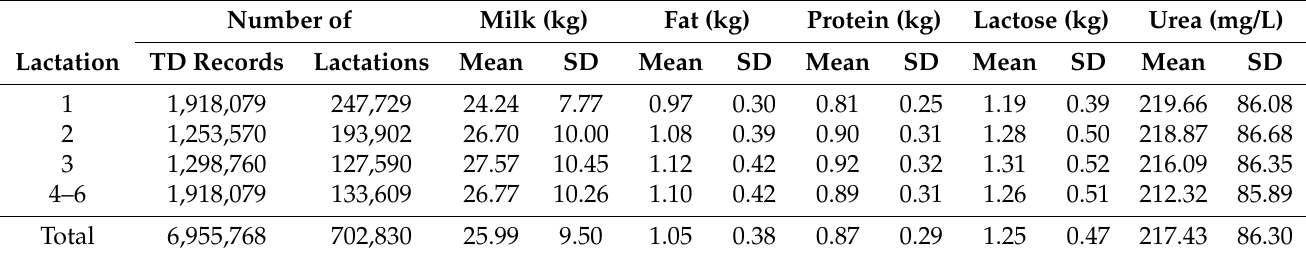
Table 1. Number of test-day (TD) records and lactations and means with standard deviations (SD) for TD milk, fat, protein and lactose yield, and milk urea content, by